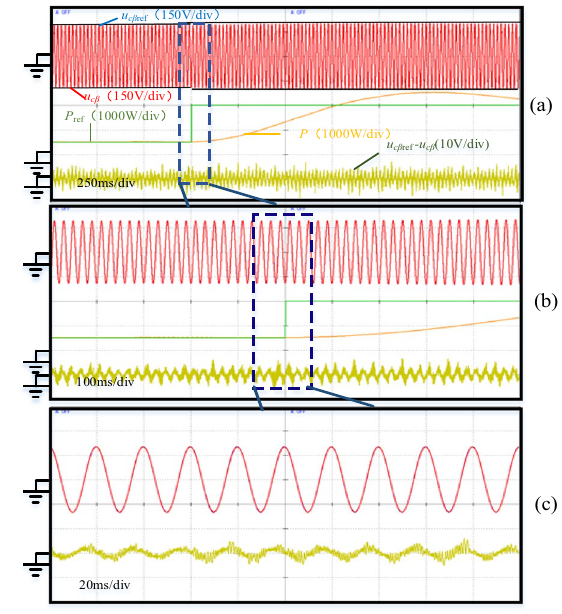
Fig. 10 Experimental waveforms during sudden change of active power with error compensation. a 250 ms/div. b 100 ms/div. c 20 ms/